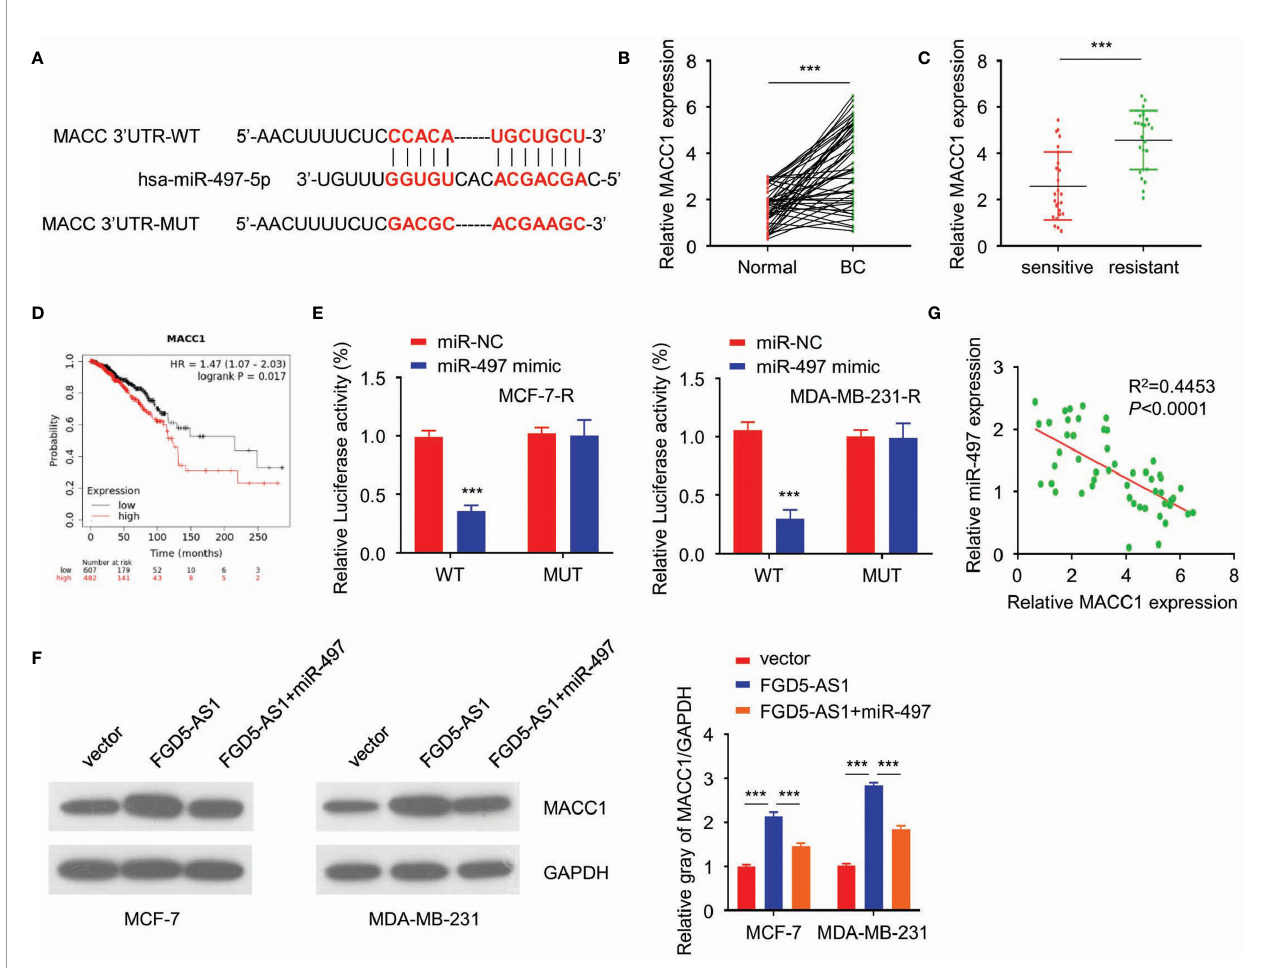
FIGURE 5 | FGD5-AS1 competitively sponges miR-497 to enhance MACC1 expression in BC cells. (A) TargetScan predicted the potential binding between miR- 497 and MACC1 sequence. (B) qRT-PCR assays indicated that MACC1 levels were signi fi cantly upregulated in BC tissues (n=50). (C) qRT-PCR assays showed that MACC1 expression was signi fi cantly increased in the radio-resistant BC tissues group (n=25). (D) KM plotter showed that higher MACC1 expression was signi fi cantly correlated with worse survival in BC patients. (E) Luciferase reporter assays indicated the direct binding between miR-497 and MACC1 in MCF-7-R and MDA-MB-231-R cells. (F) WB showed FGD5-AS1 exogenous expression increased MACC1 protein expression and could be reduced by the overexpression of miR- 497. (G) qRT-PCR assays indicated the negative relationship between miR-497 expression and MACC1 mRNA expression levels in BC tissues (n=50). Intra-group comparison ***p <